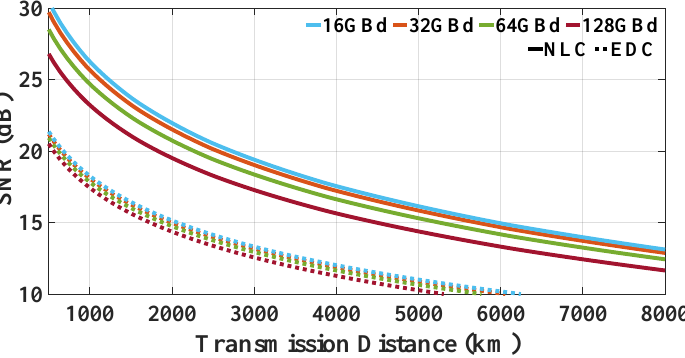
Figure 5. The central channel SNR with varying transmission distances in the Nyquist-spaced 5- channel DP-16QAM nonlinear coherent fiber system with symbol rates of 32 and 64 GBd at their optimum powers.